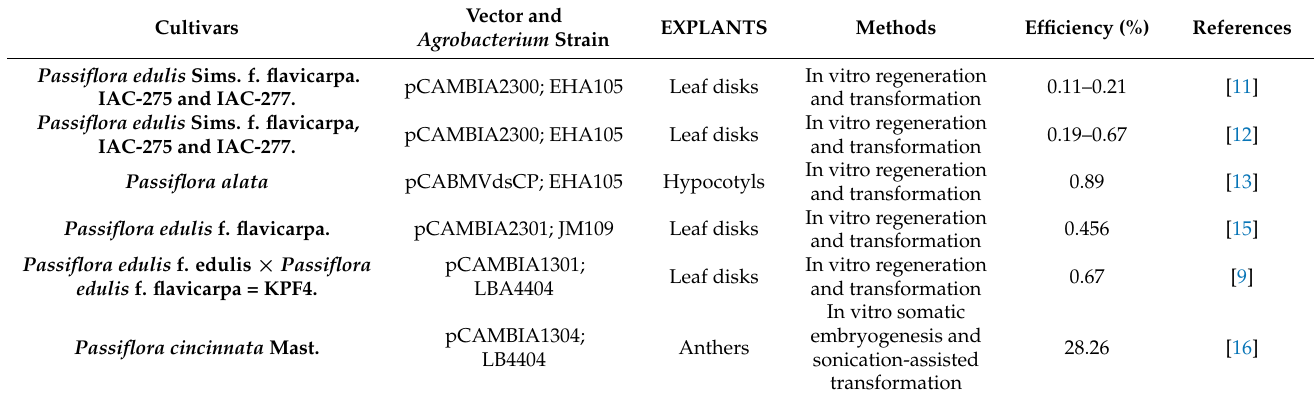
Table 3. Previous reports about the genetic transformation in Passiflora from different explant sources by in vitro methods and